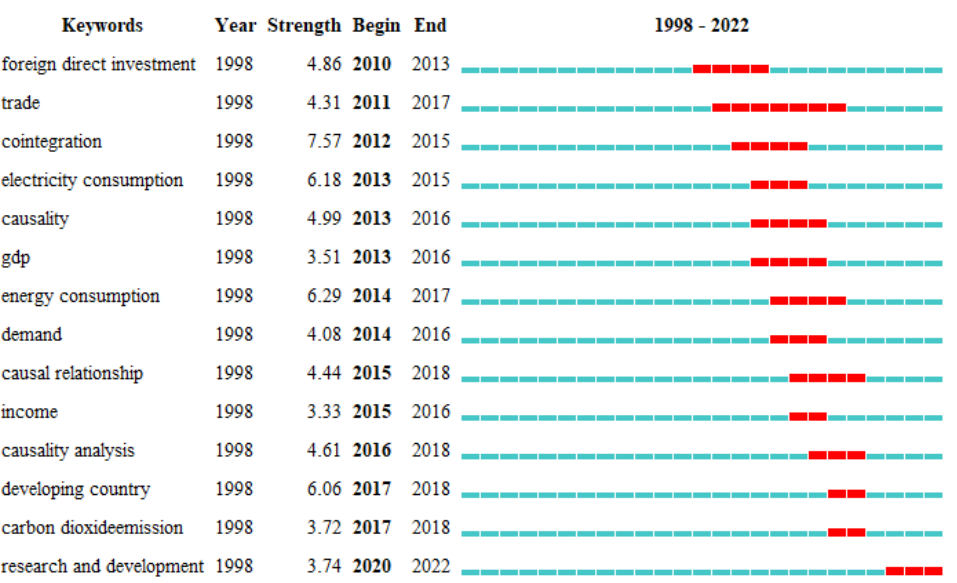
Figure 8. Top 14 keywords with the most robust occurrence explorations.